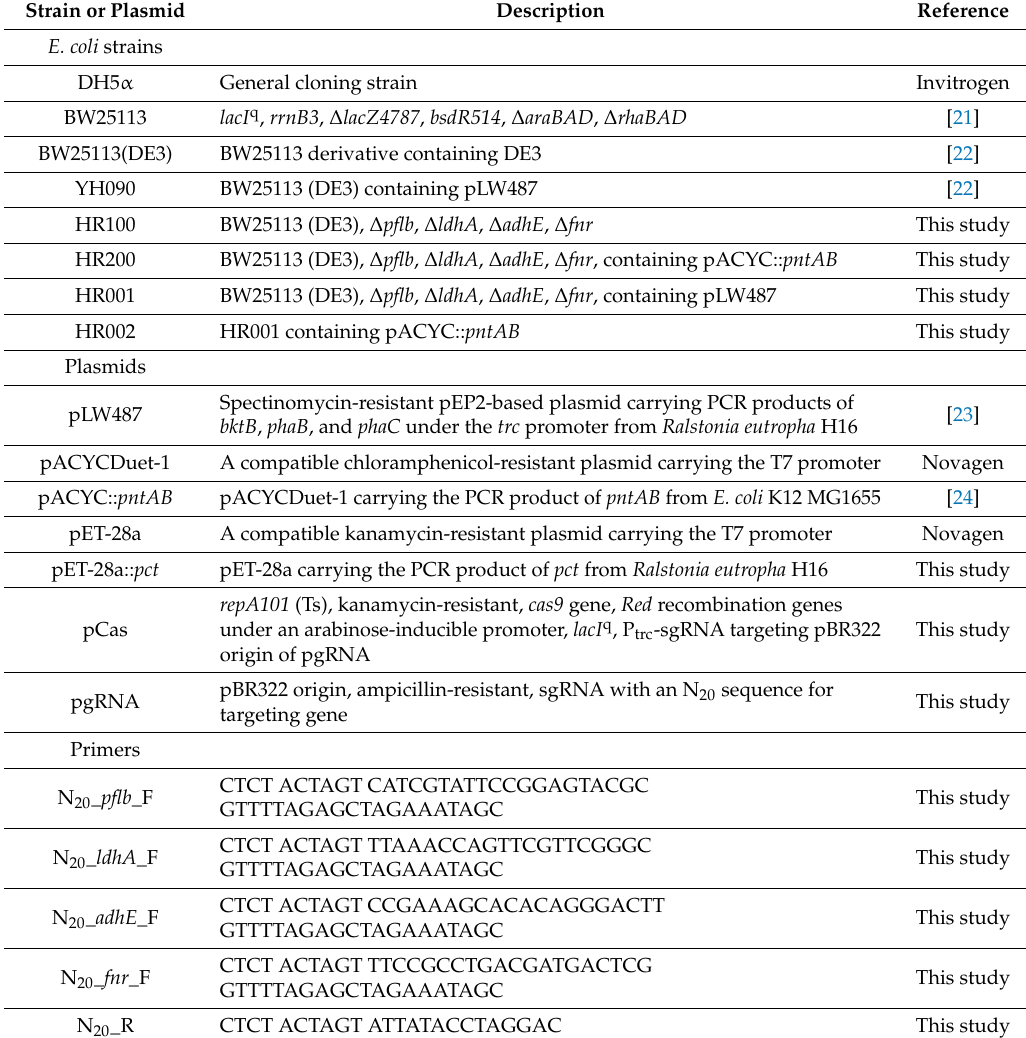
Table 1. Bacterial strains, plasmids, and primers used in this